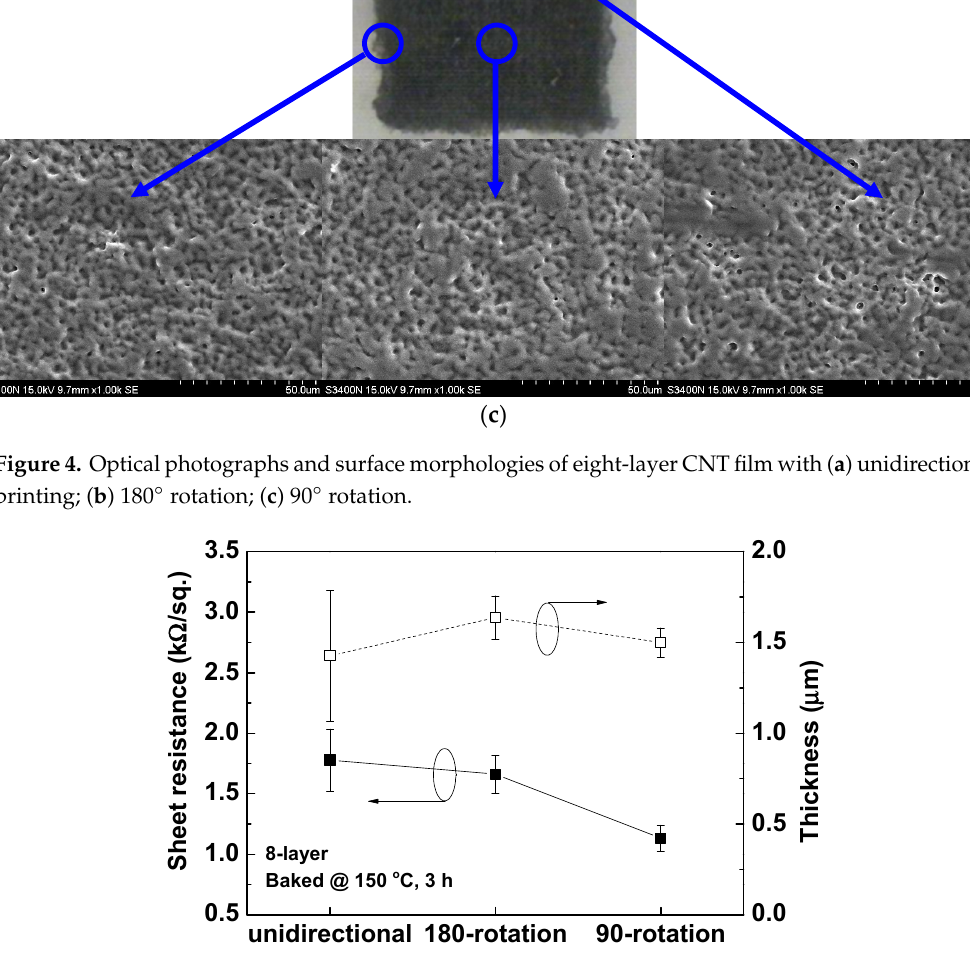
Figure 5. Sheet resistivities and thicknesses of eight-layer CNT films for by unidirectional printing, 180° rotation, and 90° rotation.